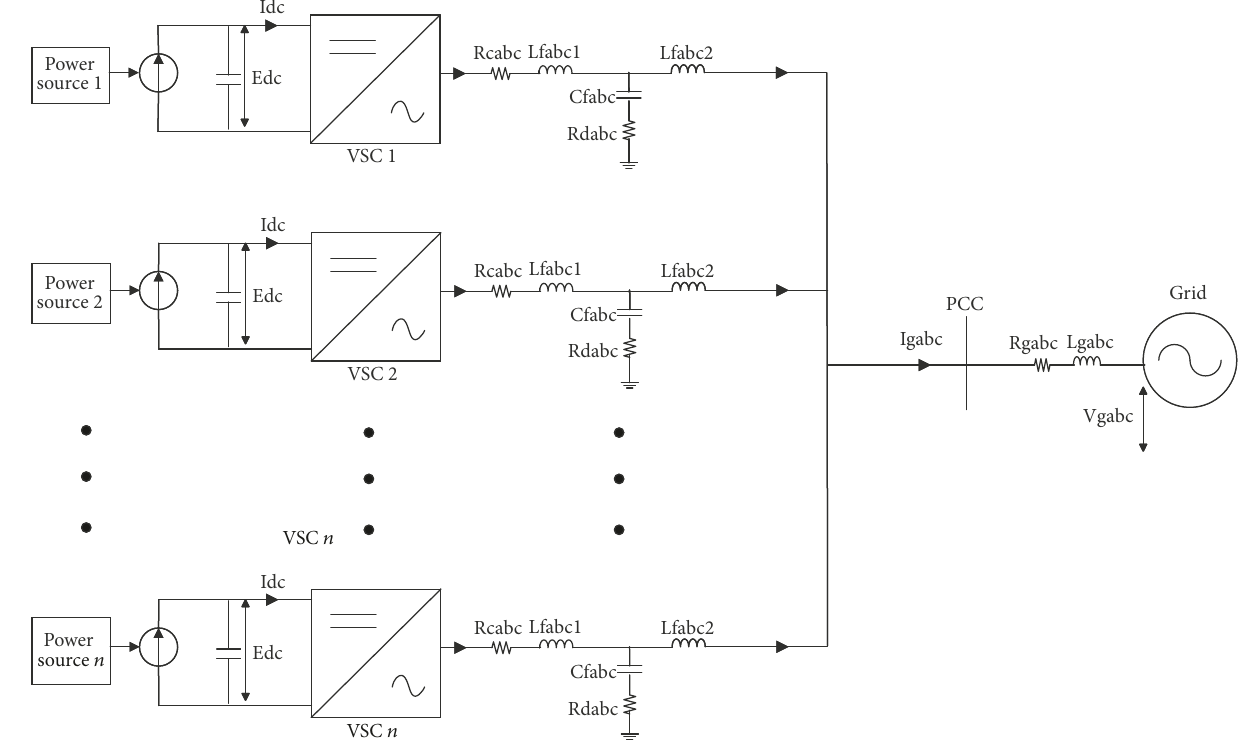
Figure 2: Multiple VSCs connected to a common point to the grid.